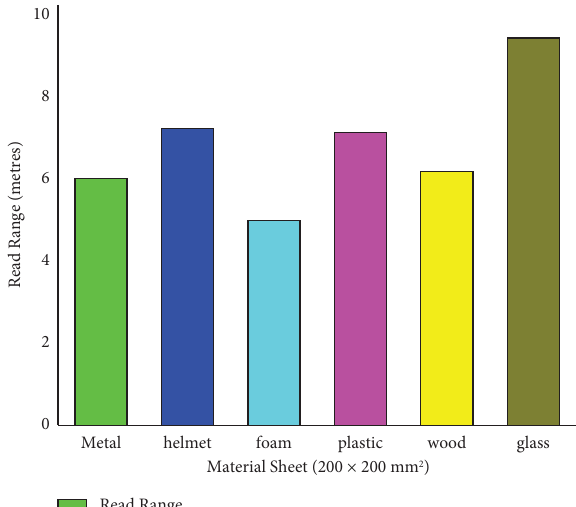
Figure 17: Read range of designed mounted on the metal sheet, ABS-plastic helmet, foam, wood, and glass